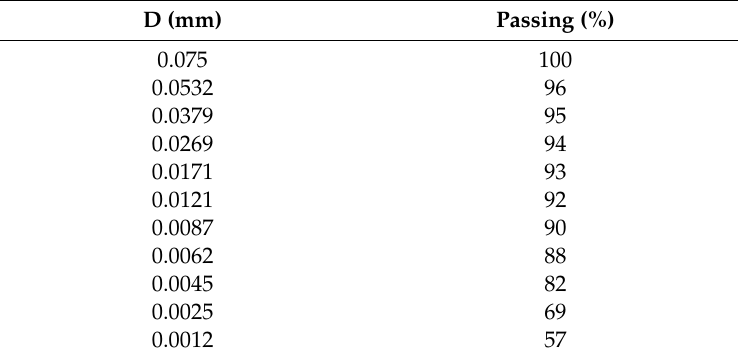
Table 2 lists the TQ0 particle sieve fraction. Table 2. TQ0 particle sieve